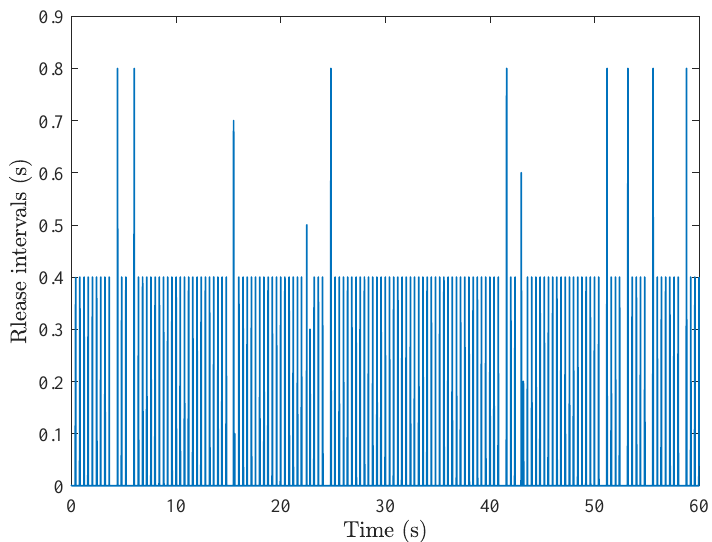
Figure 9. Event-triggered instants of sensor 3.